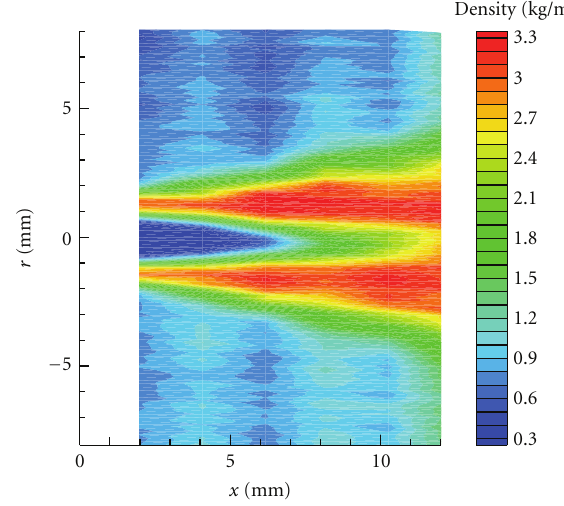
Figure 20: Hydrogen density for a coaxial LN 2 /H 2 injection for the test case D4 in Figure 19 ( T N al.